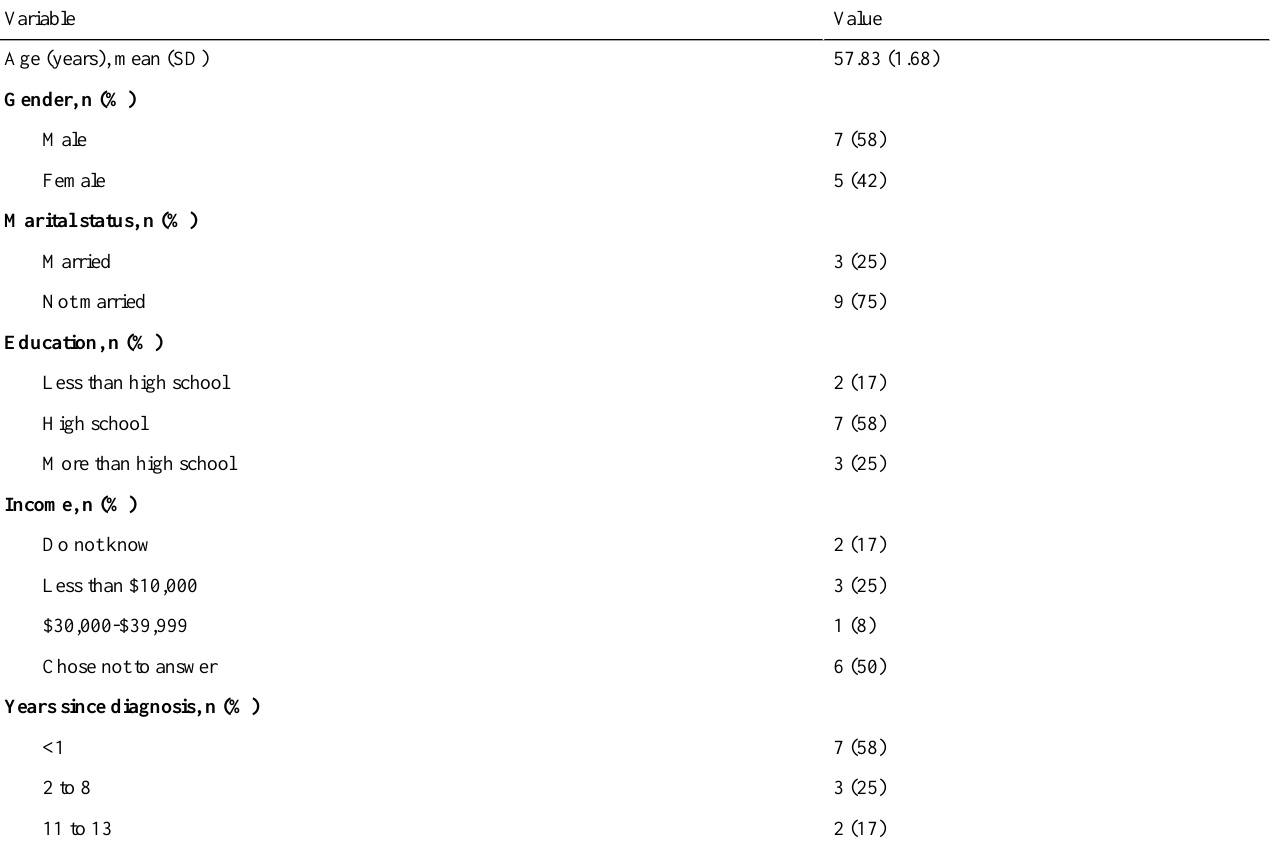
Table 1. Demographic and health characteristics of the study population